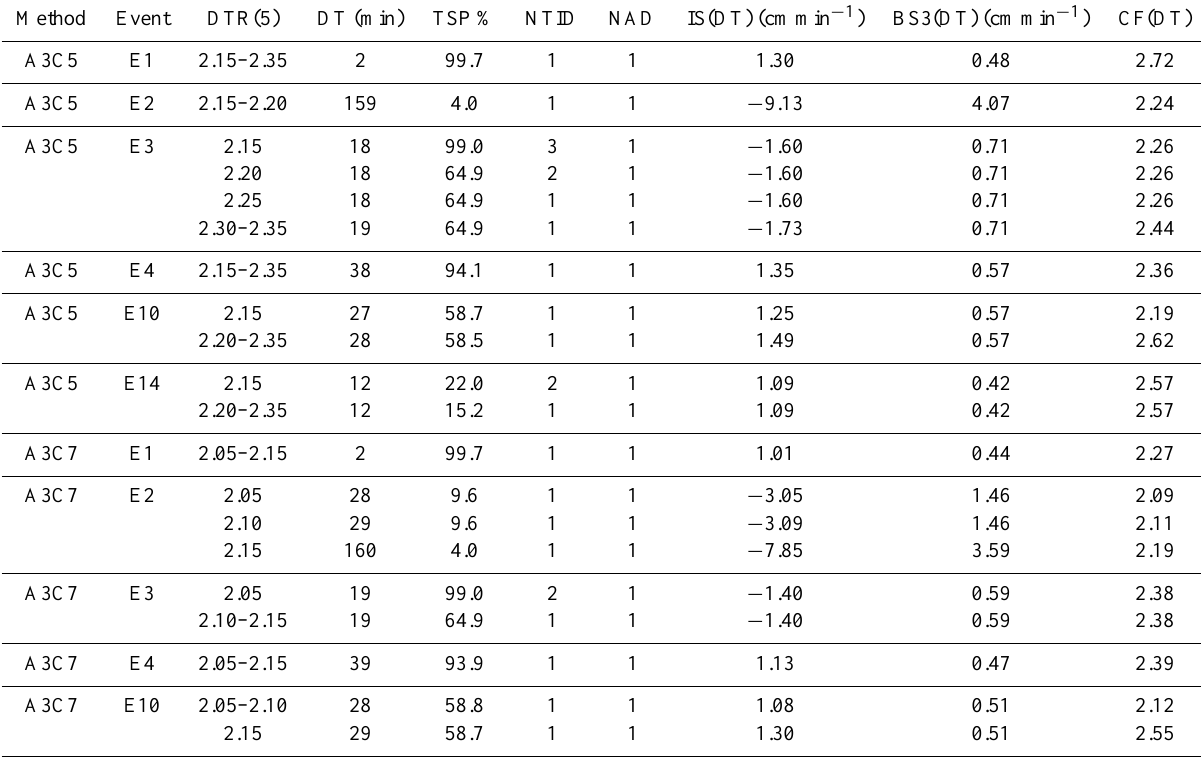
Table 6. Detection results for the configurations A3C5 and A3C7 for all events detected within the respective interval DTR(5). DTR A3C5 (5) ranges from 2.15–2.35, while DTR A3C7 (5) ranges from 2.05–2.15 (see Fig. 6). The value at the detection time of functions IS, BS3 and CF3 is also given together with the Delay Time (DT), the Tsunami State Duration (TSP) and the Number of Tsunami Interval Detections (NTID) falling within the Tsunami Interval (TI), and the Number of Acceptable Dections (NAD) falling within the Detection Window (DW). To reiterate, the only detections within the DW are TEDA detections, though the NTIDs are not considered false detections and contribute to